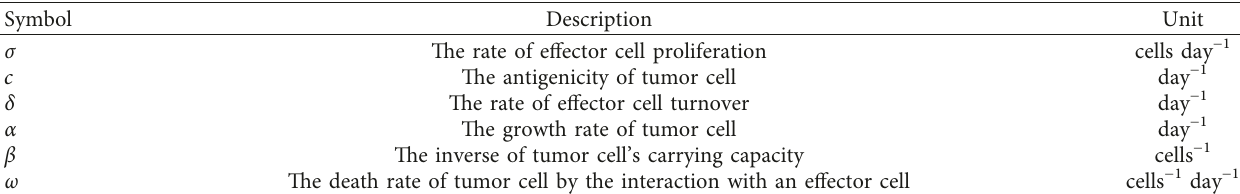
Figure 1: Schematic diagram of model (1) for interaction of tumor cells and immune cells (commonly called effector Table 1: Variables and parameters in model (1).